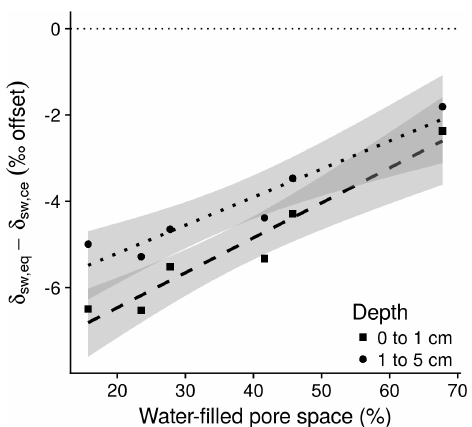
Figure 5. Relationships between water-filled pore space and the dif- ference between estimates of the δ 18 O of soil water in equilibrium with CO 2 , as estimated from gas flux measurements ( δ sw , eq ), and that estimated by cryogenic extraction ( δ sw , ce ) at depths of 0–1cm (squares) and 1–5cm (circles). Dashed lines and shaded areas indi- cate the linear regressions and associated 95% confidence intervals for the two sampling